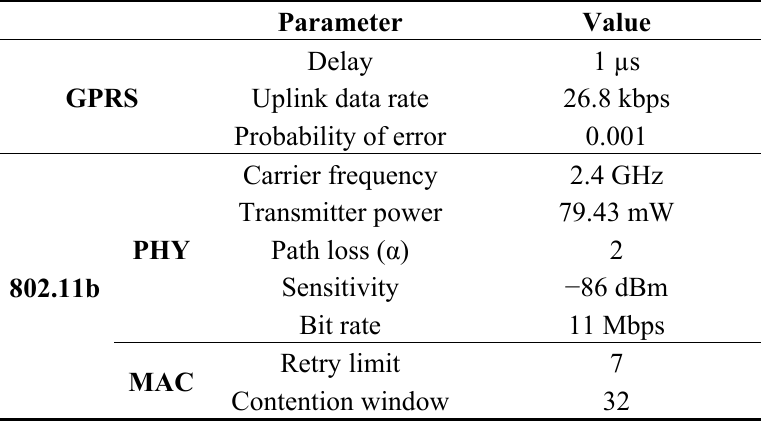
Table 11. Summary of the most important parameters configured for each communications technology. Parameter